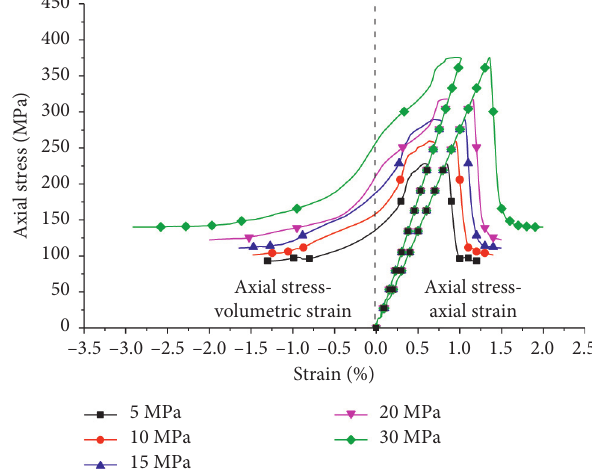
Figure 10: Simulated stress-strain curves for different confining pressures. Table 5: The comparison between simulated strength and experimental